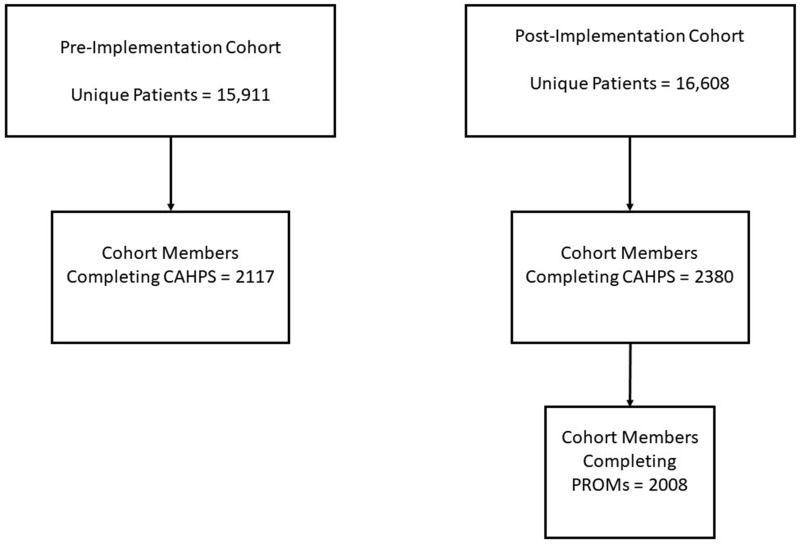
Flow chart of study cohortsCAHPS: Consumer Assessment of Healthcare Providers and Systems; PROMS: patient-reported outcome measures